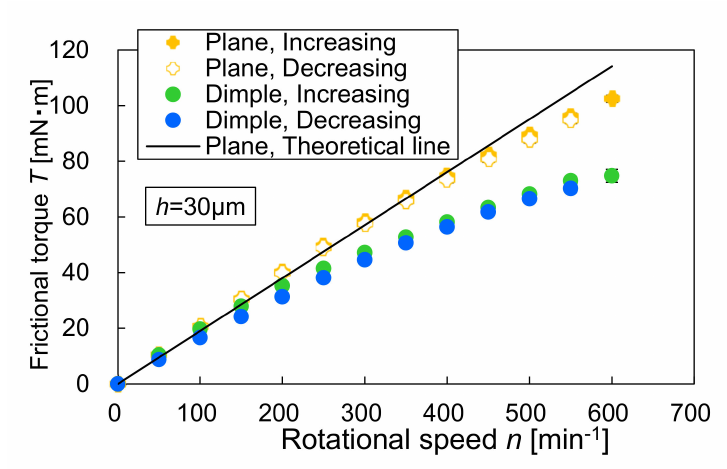
Figure 12. The relationship between frictional torque and rotational